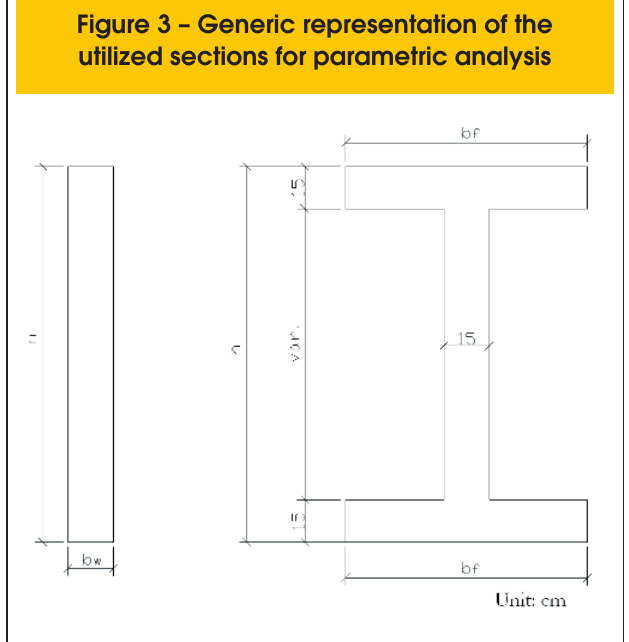
Table 1. Thus, the Britain and Brazilian codes recommend unsafe limits for rectangular beams in transitory phases. Figure 3 – Generic representation of the